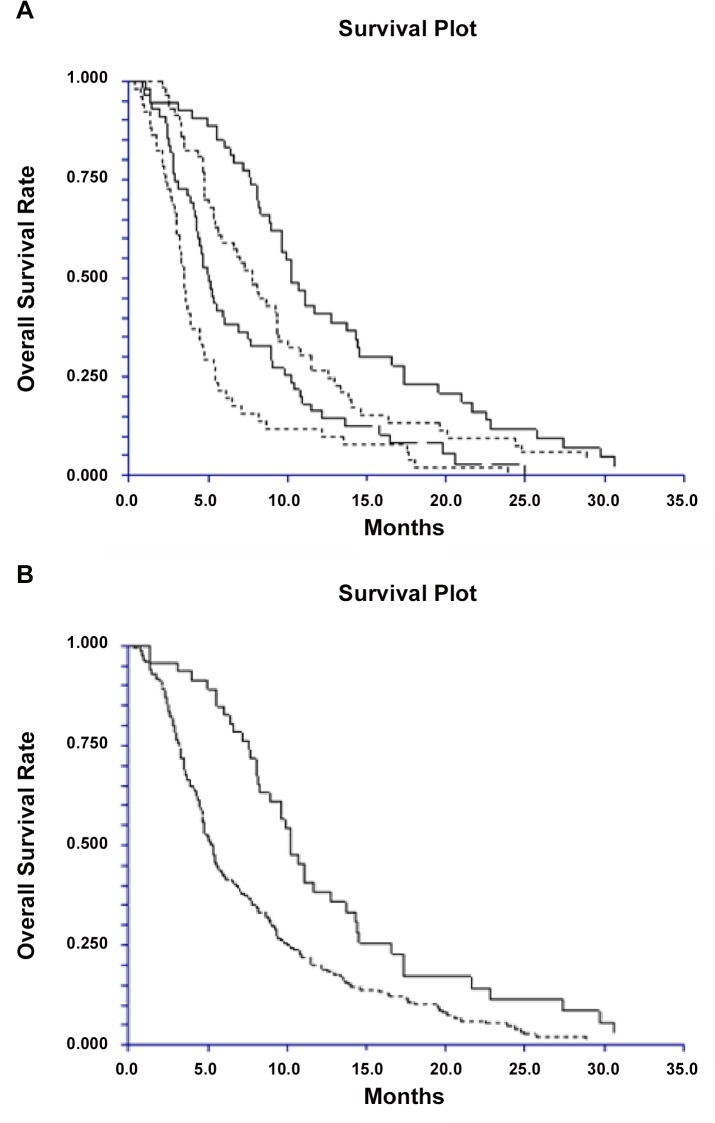
Kaplan Major Plots of OS probabilities.A. Patients are grouped by quartiles of cfDNA (from the right) lowest, second lowest, second highest and highest quartile of cfDNA. The median OS according to cfDNA quartiles were; 10.2 months (95% CI 8.9–12.8), 7.8 months (5.7–9.3), 5.0 months (4.3–6.0) 3.5 months (3.0–3.9), respectively. B. Patients are grouped by the upper normal range as defined by mean cfDNA+2SD in the control group (7100 alleles per ml.) Low risk group (full line), Median OS, 10.2 months (8.3–11.7). High risk group (dotted line) Median OS, 5.2 months (4.6–5.9). HR 1.78, p = 0.0006.